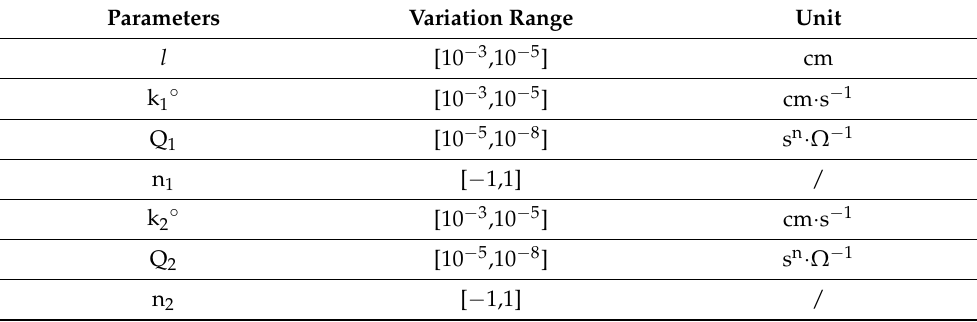
Table 1. Variation interval of different parameters.